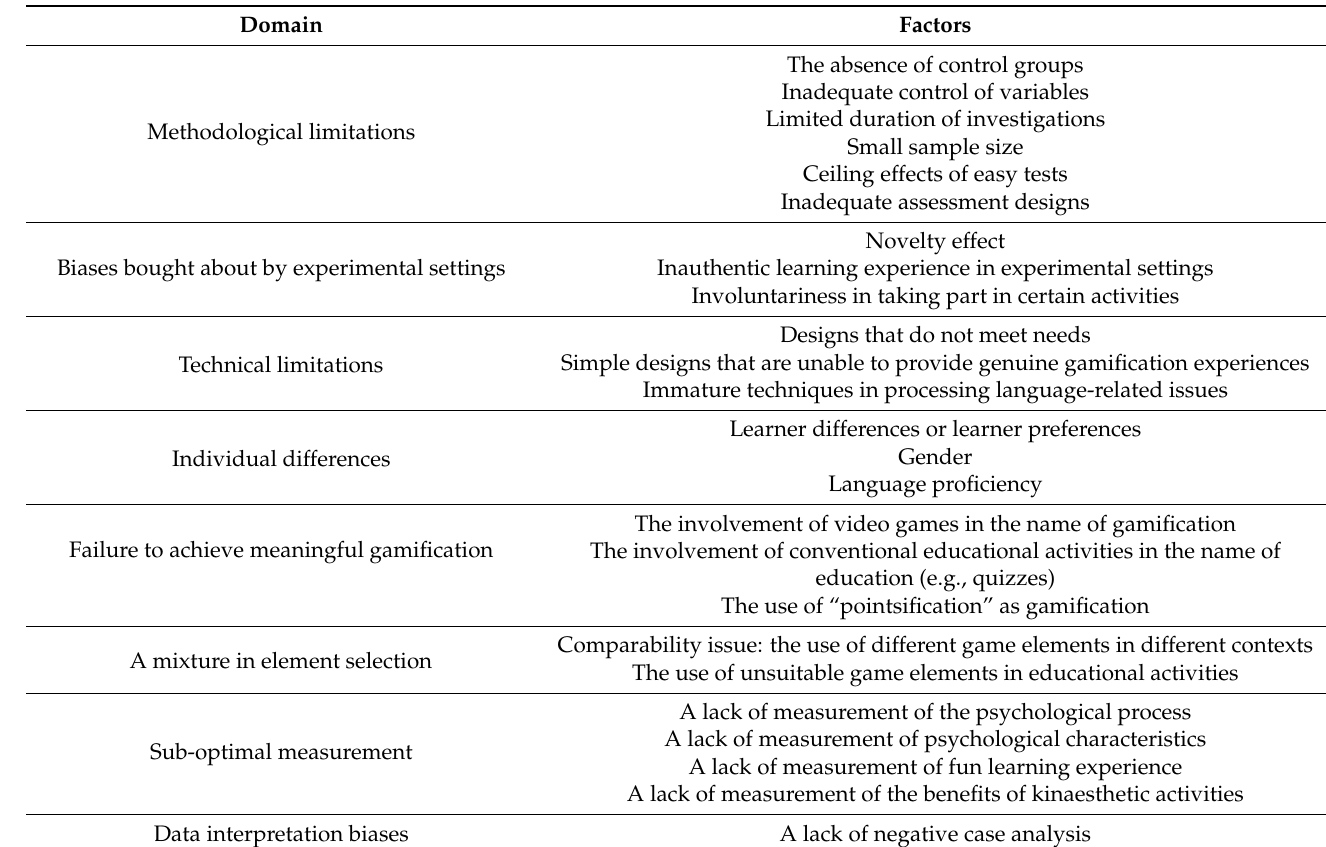
Table 5. Contributing factors that influence the effectiveness of gamified FLL